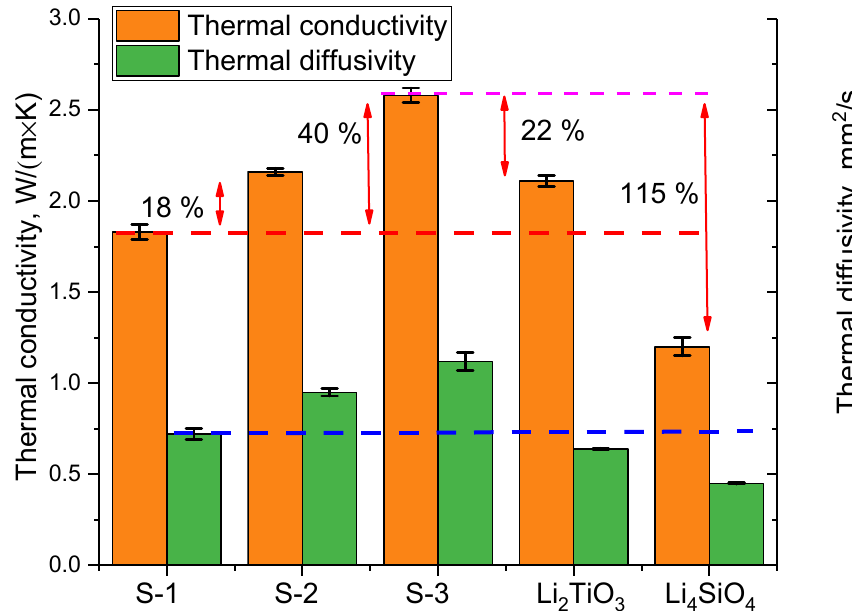
Figure 6. Results for the comparison of thermophysical parameters on the studied ceramics.